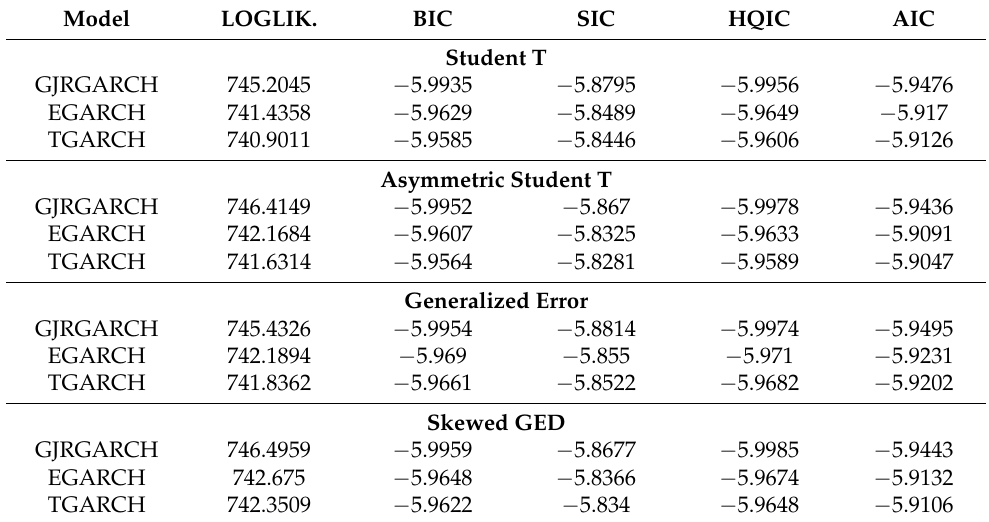
Table A1. GARCH model selection of PSX-100 closed returns during COVID-19